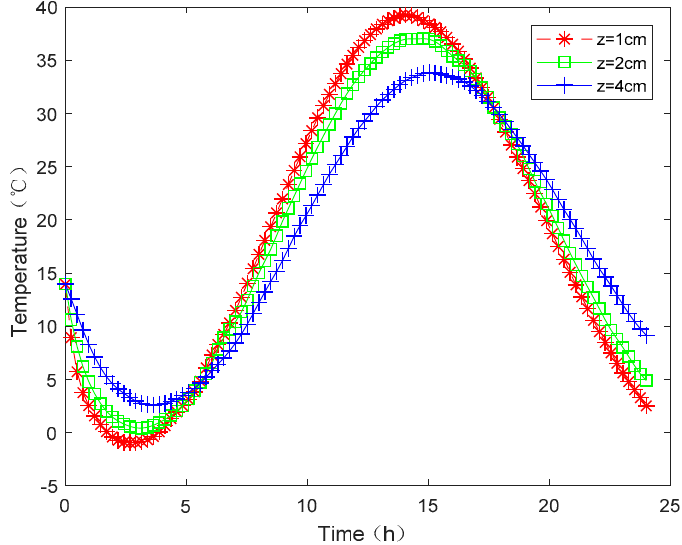
Figure 8. Calculated temperature in the asphalt pavement structure.